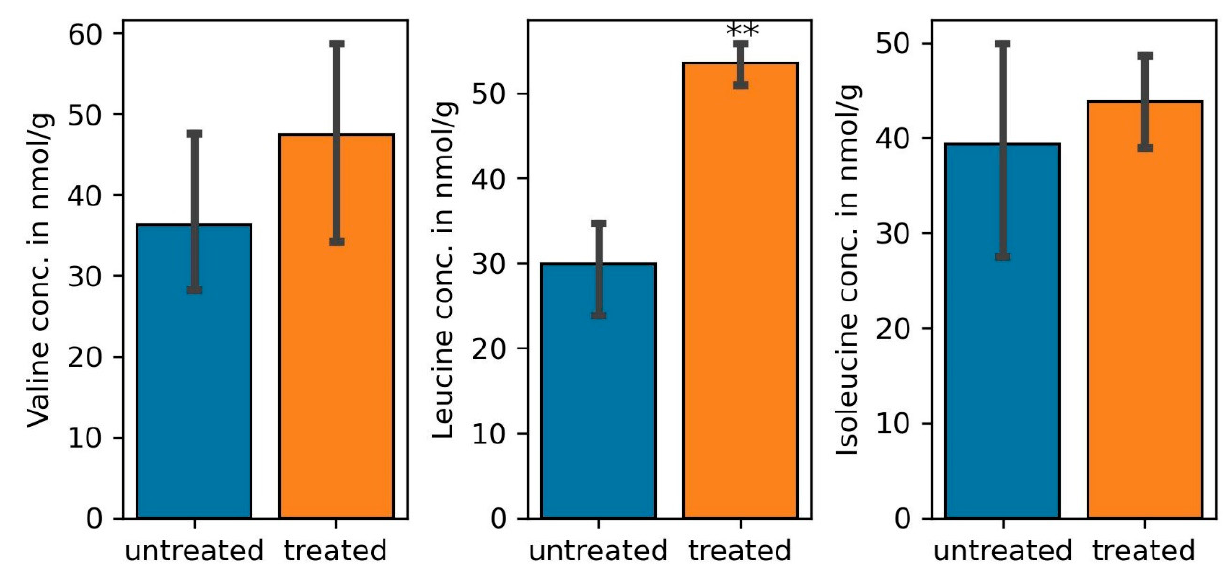
Figure 5. Quantity of branched chain amino acids, valine, leucine, and isoleucine in common bean nodules treated with 300 mM NaCl (treated) compared to those not treated with the salt (untreated). (one-way ANOVA; ** indicates p ≤ 0.001).